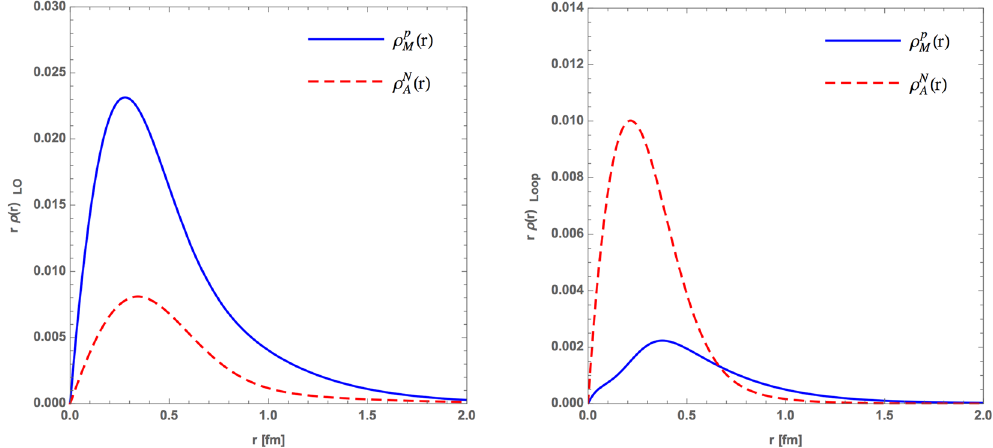
Figure 7. Comparisons between the magnetic and axial distributions in r -space for the LO (left panel) and loop (right panel)